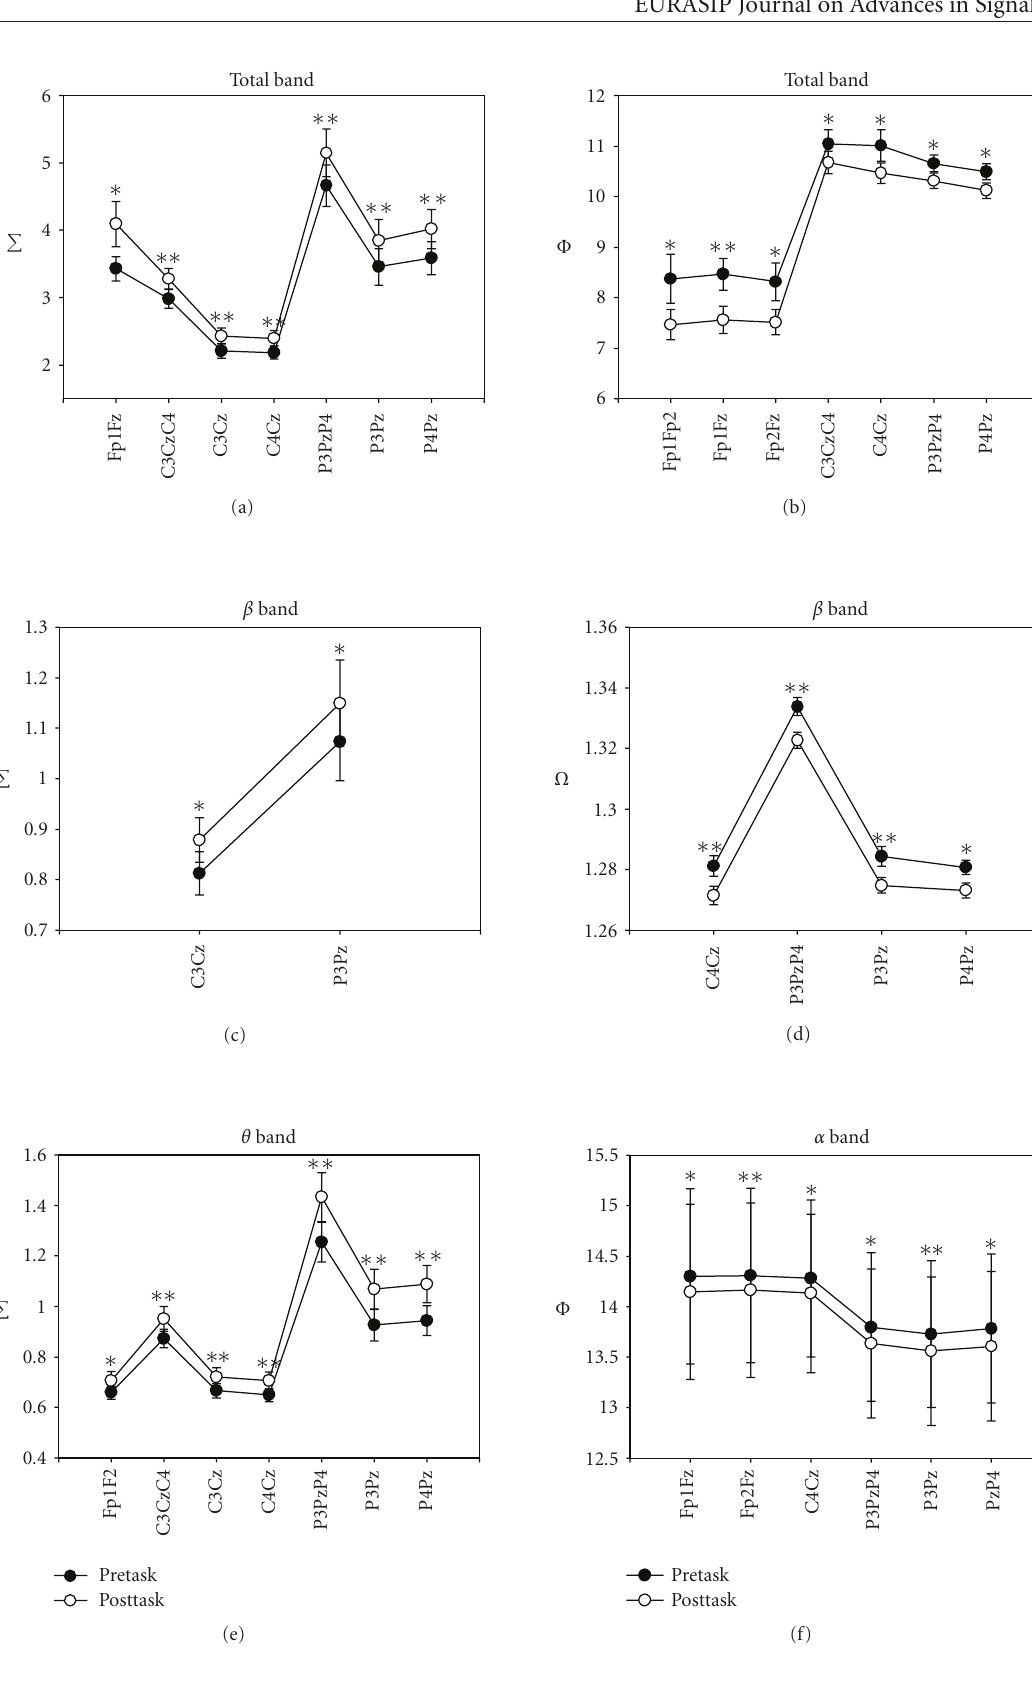
Figure 6: Comparison of multichannel linear descriptors in total, β , α , and θ frequency bands between two sessions. Pretask (before task), posttask (immediately after task). ∗ P < . 05, ∗∗ P < . 005, statistical significance of di ff erence between two